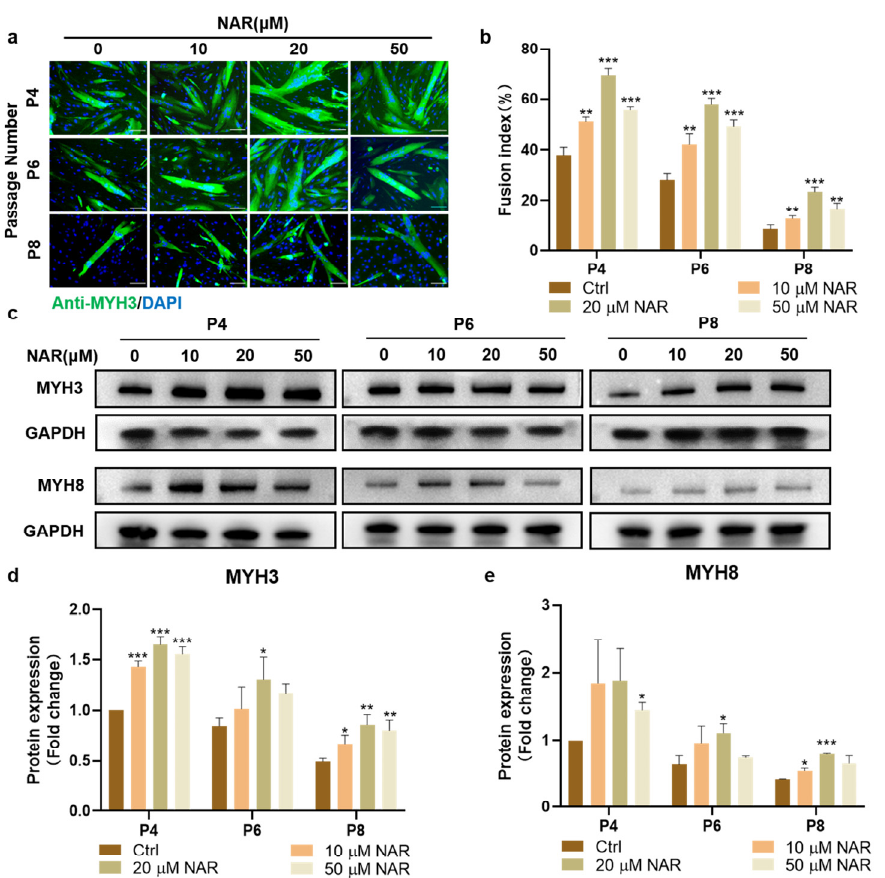
Figure 3. NAR increased myogenesis of PSCs at different passages. ( a ) Representative immunofluores- cent images of differentiating PSCs at different passages after three days of induction in differentiation medium supplemented with NAR (0, 10, 20, 50 µ M). Green, anti-MYH3; blue, DAPI. Scale bar, 100 µ m. ( b ) Fusion index as a percentage according to immunofluorescent images ( n = 3 biological replicates). ( c ) Western blot analysis of MYH expression in differentiating PSCs at different passages after three days of differentiation in the absence or presence of NAR (10, 20, 50 µ M). ( d , e ), Quantification of MYH3 and MYH8 expression according to ( c ). The bar chart presents the quantification of blot band intensity, normalized to GAPDH levels, and presented as a fold change relative to the ctrl sample of P4, which was set to one. Error bars represent mean ± SD. The asterisk indicates a significant difference from the ctrl group at the same passage. * p < 0.05, ** p < 0.01, *** p < 0.001.